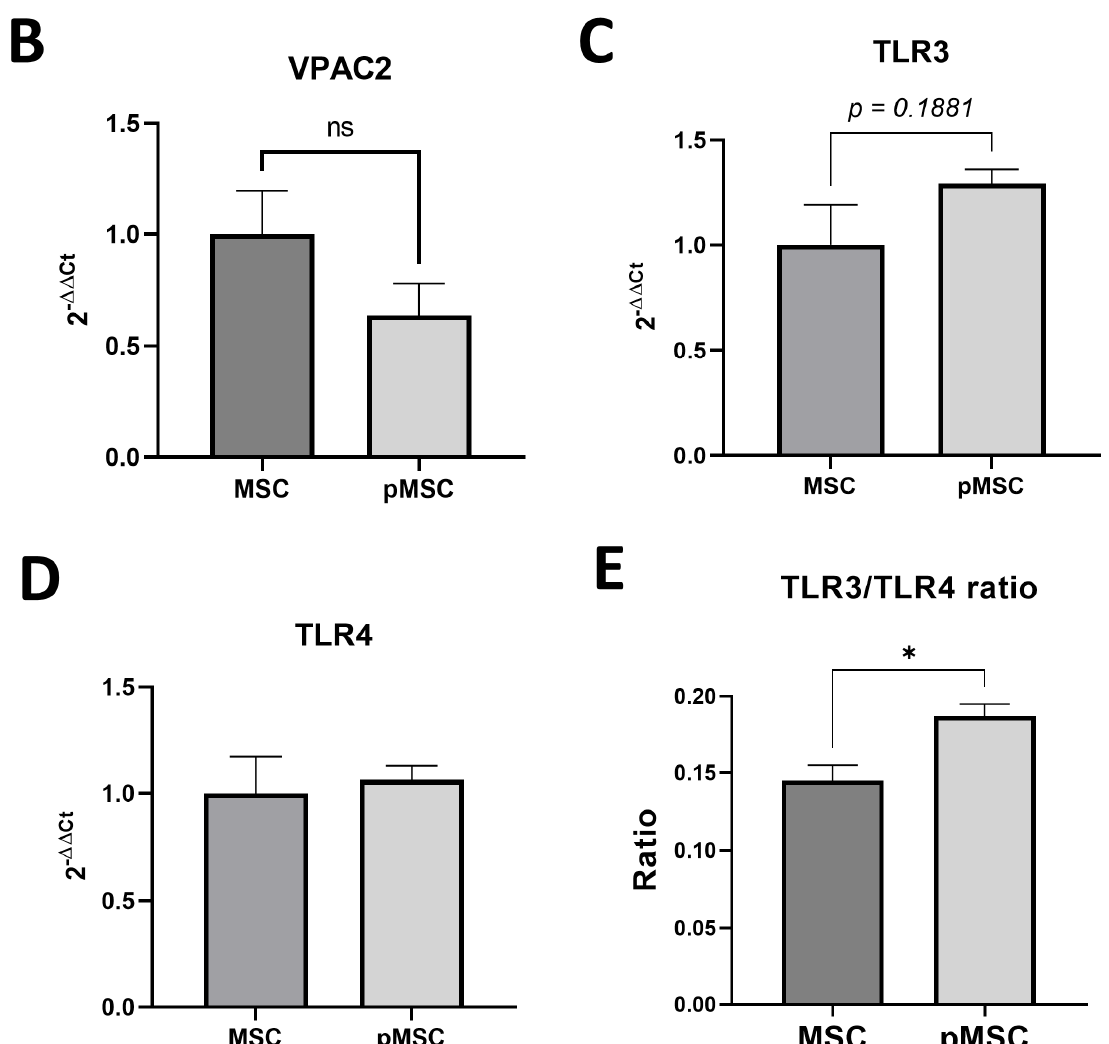
Figure 1. Polarized PACAP-treated MSC maintain mesenchymal phenotype. ( A ). Immunopheno- typing of PACAP-treated MSC in flow cytometry presents positive expression of the mesenchymal markers CD106 (>50%), CD29 (>80%), CD44 (>70%), CD73 (>60%) and sca-1 (>40%) but negative expression of the hematopoietic markers CD45 (<8%), and CD11b (<5%). Graphs represent flow cytometry histograms for the expression of the different markers. The negative control histogram is presented with the blue filled histogram. ( B ). Both naïve (N = 4) and PACAP-treated MSC (N = 3) expressed detectable levels of VPAC2 receptor mRNA, as detected in real-time PCR. Since the activa- tion of Toll-like receptor 3 (TLR3) is an established marker of the MSC anti-inflammatory phenotype (MSC2) [15], we administered pituitary adenylate cyclase-activating peptide (PACAP), a neuropep- tide with anti-inflammatory properties that is known to upregulate TLR3 and vice versa with TLR4, at 20 nM for 4 days to establish the anti-inflammatory MCS phenotype (MSC2). PACAP treatment of MSC in vitro (pMSC, N = 5) did not increase significantly the expression of TLR3 ( C ) or TLR4 ( D ) but increased the TLR3/TLR4 gene expression ratio ( E ) compared with naïve MSC (N = 4), as detected in real-time PCR. All graphs present mean ± SE. * p < 0.05, Student t -test. ns = non- significant.